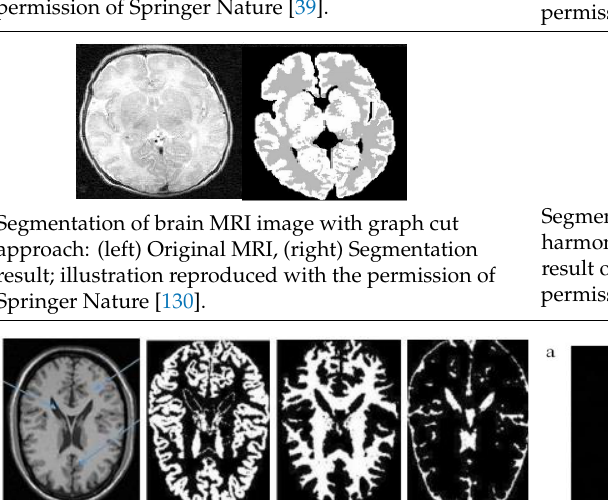
Tissue segmentation of brain MRI image with Gaussian Markov Models (GMM): (left) Brainweb sample slice, (middle) Ground truth and (right) Result of segmentation; Ground truth and (right) Result of illustration reproduced with the permission of Springer reproduced with the illustration reproduced illustration segmentation; illustration reproduced with the Nature illustration reproduced permission of Springer Nature [134]. permission of Springer Nature [134]. permission of Springer Nature [134].